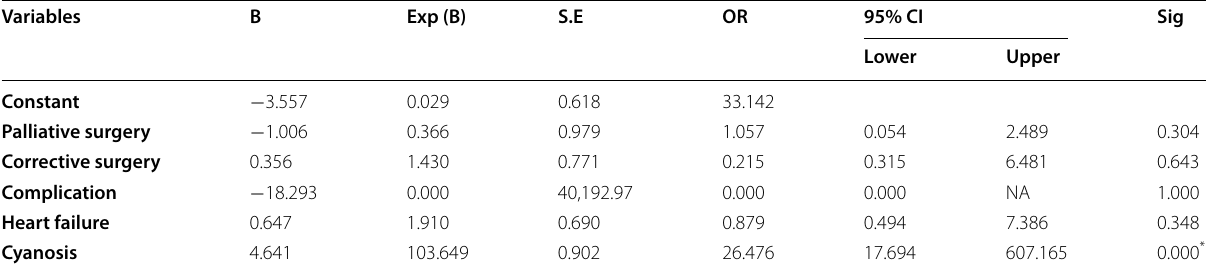
OR Odds ratio CI Confidence interval NA not applicable due to low event rate * : statistically significant p The model was well calibrated (Hosmer – Lemeshow chi-square: 0.437, p